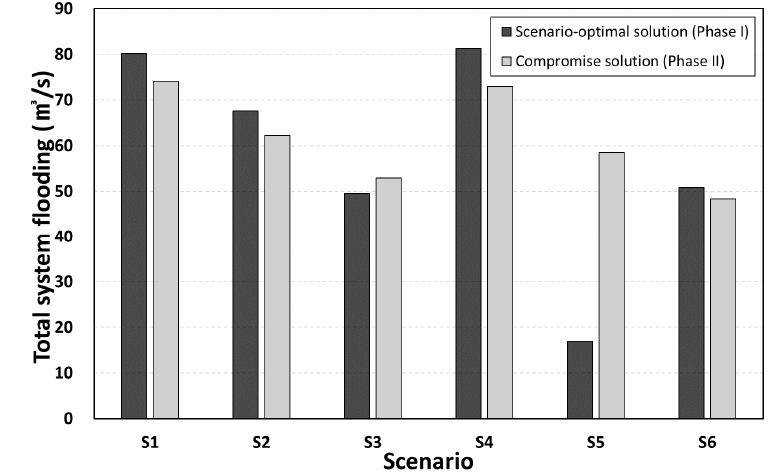
Figure 10. Comparison of the system performance between scenario-optimal solutions and multi-scenario-based compromise solution.